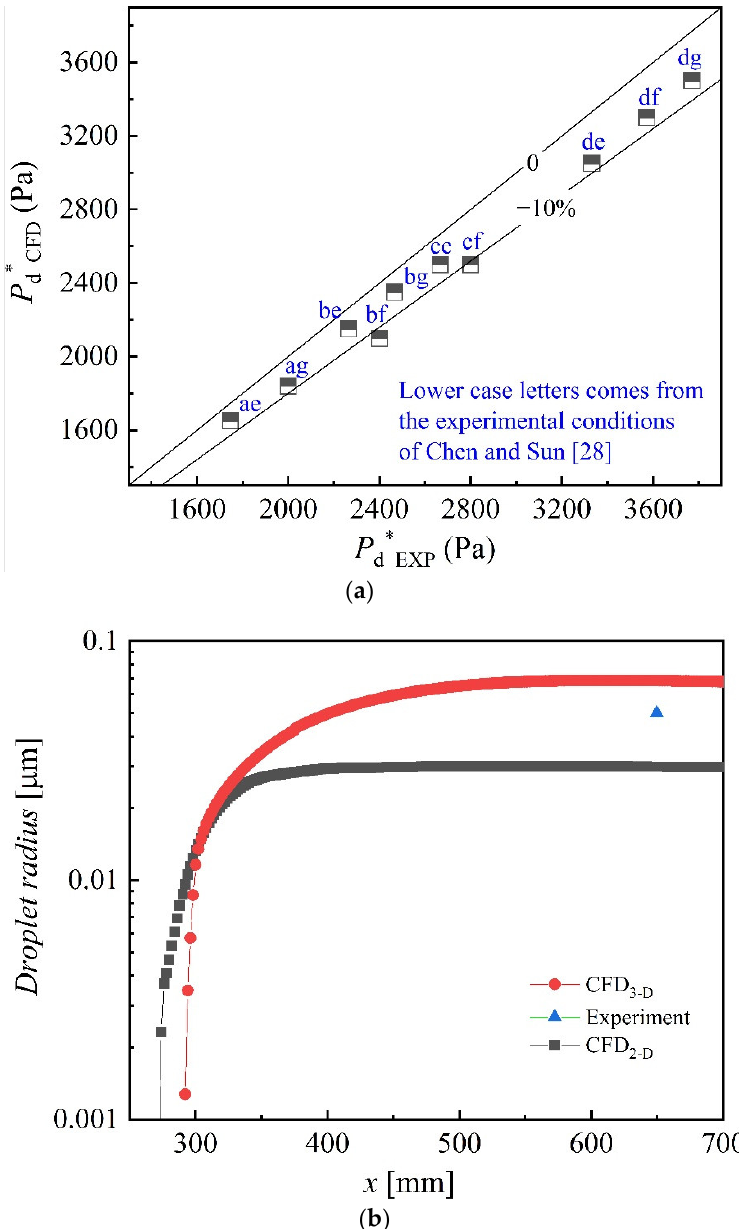
Figure 4. ( a ) P d * comparisons of CFD and experimental results. ( b ) Droplet radius comparisons of CFD and experimental results .